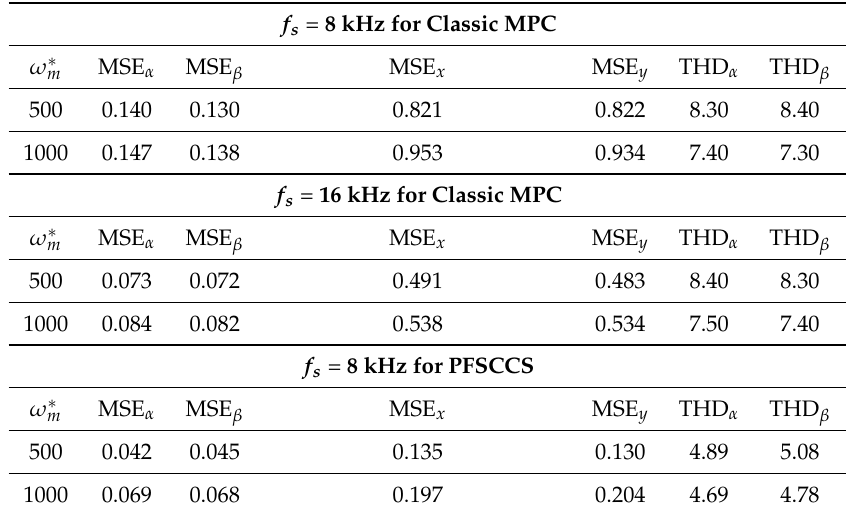
Table 3. Experimental performance test of stator currents ( α - β ), ( x - y ), MSE (A), THD (%) between classic MPC and the PFSCCS at different rotor speeds (rpm).